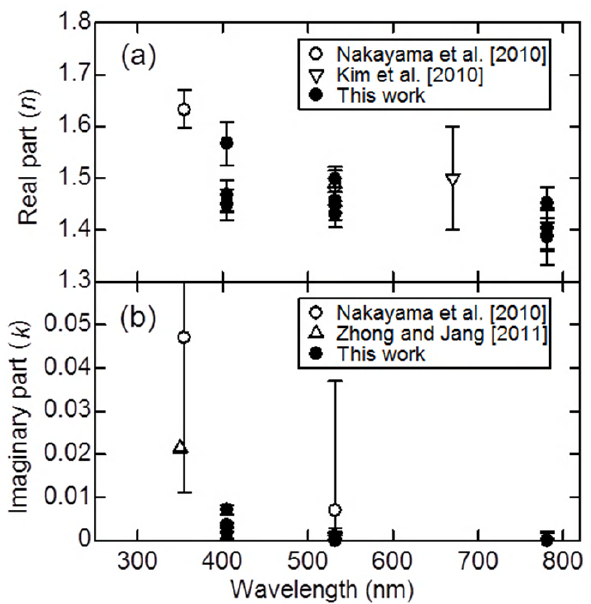
864 Fig. 5. Wavelength dependence of the (a) real and (b) imaginary Figure 5. Wavelength dependence of the (a) real and (b) imaginary parts of the RI values for 865 parts of the RI-values for the toluene-SOAs determined in the the toluene-SOAs determined in the present study and reported in the literature (Nakayama et 866 present study and reported in the literature (Nakayama et al., 2010a; al. 2010a, Kim et al. 2010, Zhong and Jang 2011). 867 Kim et al., 2010; Zhong and Jang